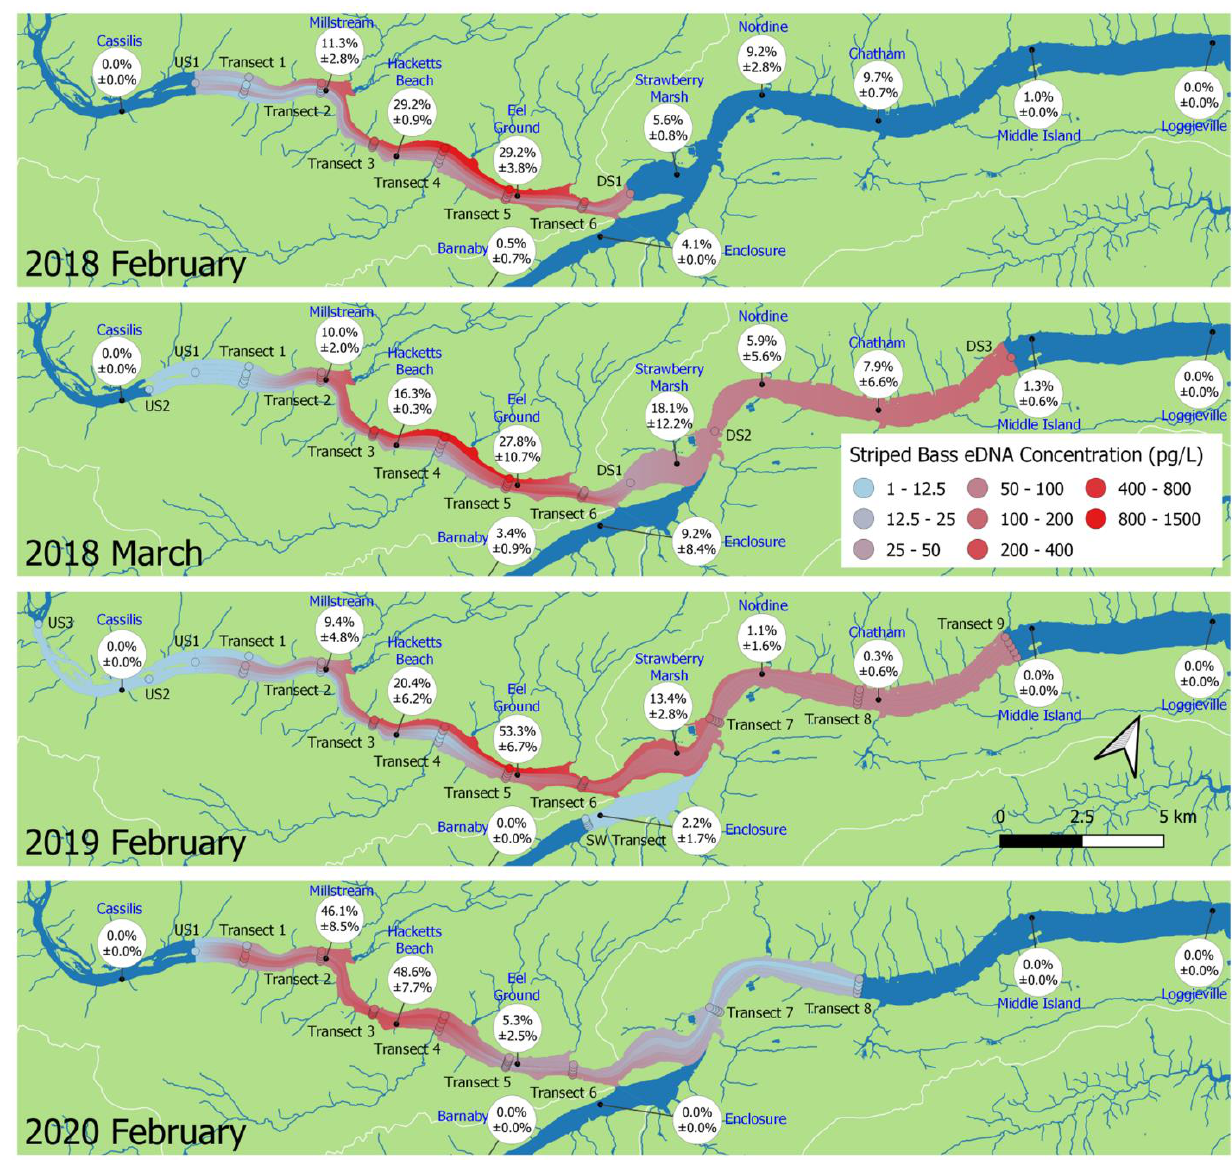
Figure 2. Interannual comparison of back-transformed site mean striped bass eDNA concentration (pg/L) and mean percent of daily detections ± standard deviation at each acoustic receiver in February 2018, March 2018, February 2019 and February 2020. Transect, upstream (US) site, downstream (DS) site and acoustic receiver (blue) names are indicated. All sites were sampled at the surface, on a falling tide. Dark blue waters were outside of the sampled area.